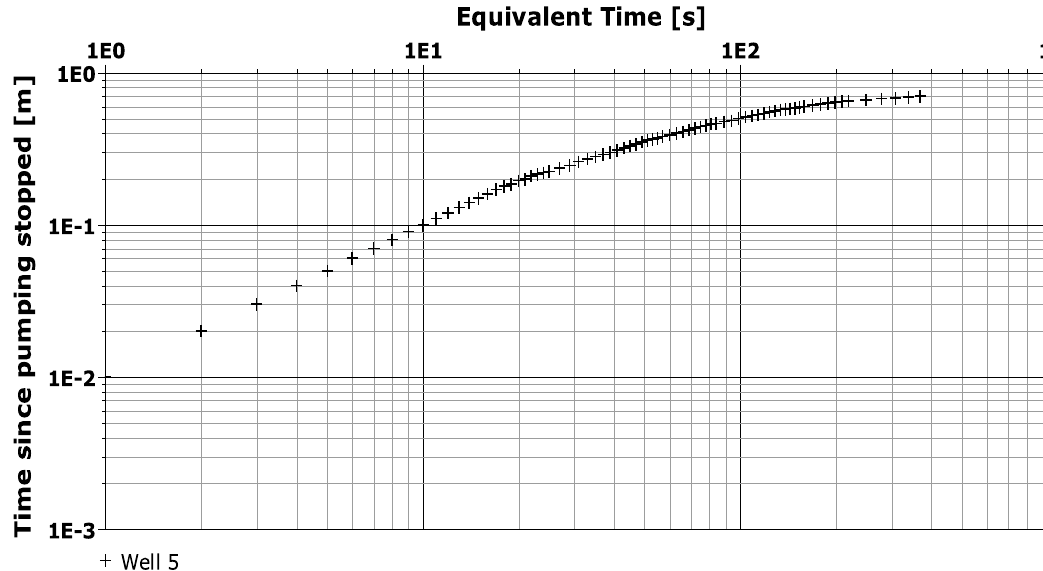
Fig. 10 Plotting of recovery rate of well-5 using aquifer mapping